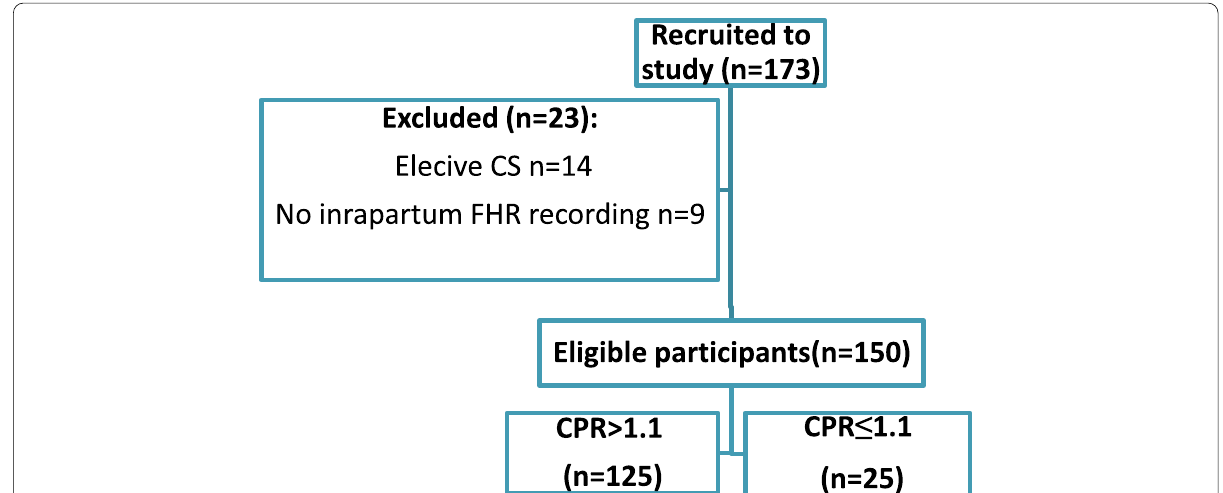
Fig. 1 Flowchart showing inclusion of the study participants. CPR cerebroplacental ratio, CS cesarean